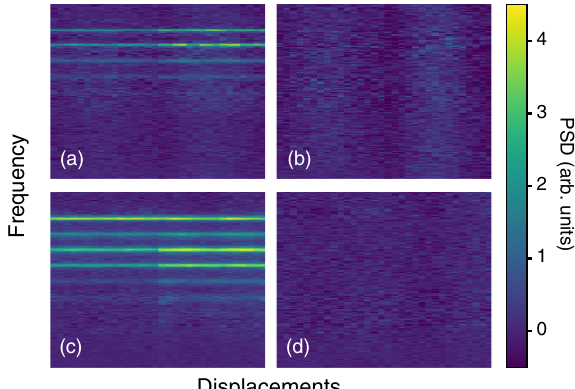
FIG. 10. Justification of the parity constraint for tomography of parametrically prepared states. (a) Raw data f [Fig. 4(b), left], including transient PSDs for all displacements α . (b) The difference of the raw data under parity transformation ˜ S ˜ S f ð ω ; þ α Þ − ð ω ; − α Þg . Panels (c) and (d) are the same as panels (a) and (b) but for the tomography data set in [Fig. 4(b),